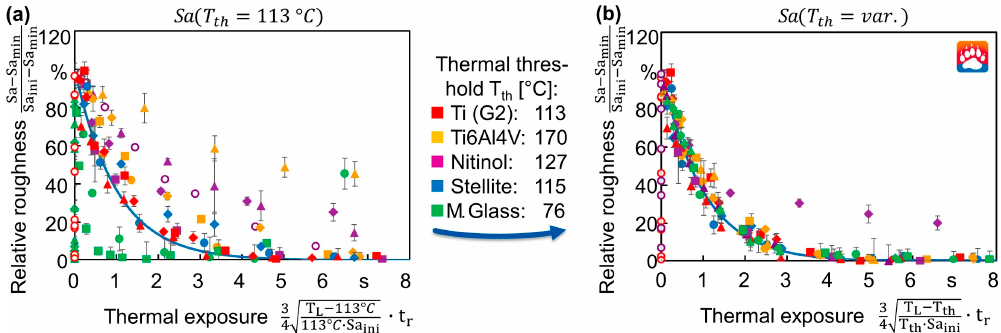
Figure 14. Validation of the multi-cycle PSC on different self-passivated materials ( a ) for the thermal threshold of titanium and ( b ) an individual thermal threshold for each material.